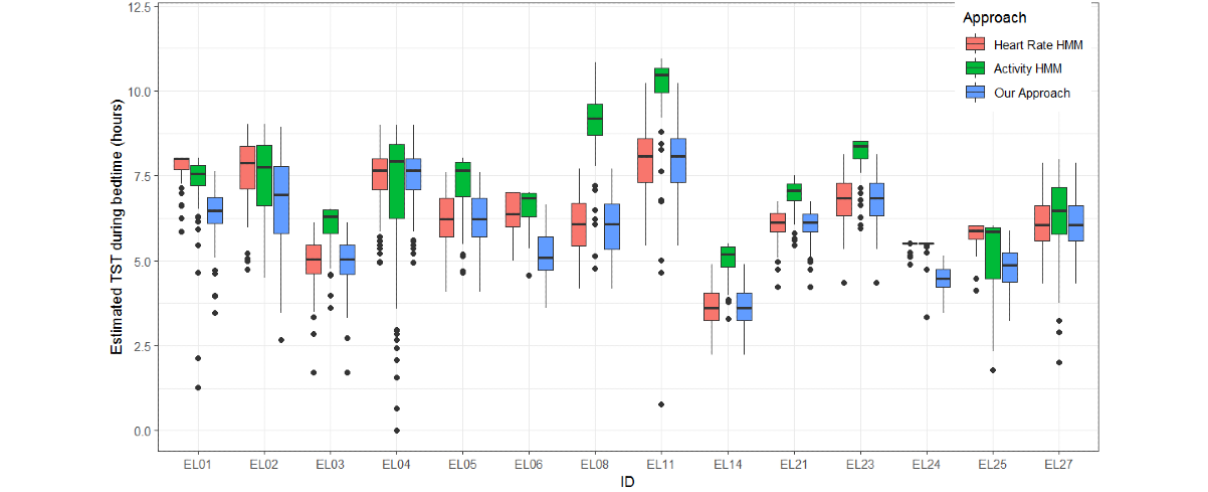
Figure 7. Boxplot of estimated daily total sleep time during bedtime at night from heart rate HMM, activity HMM, and fusion HMM (our approach) for all participants. HMM: hidden Markov model; TST: total sleep time.